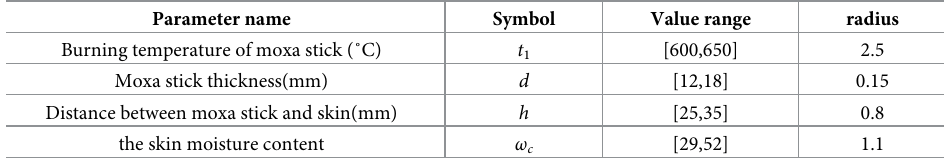
Table 5. The value range and interval radius of moxibustion parameters.